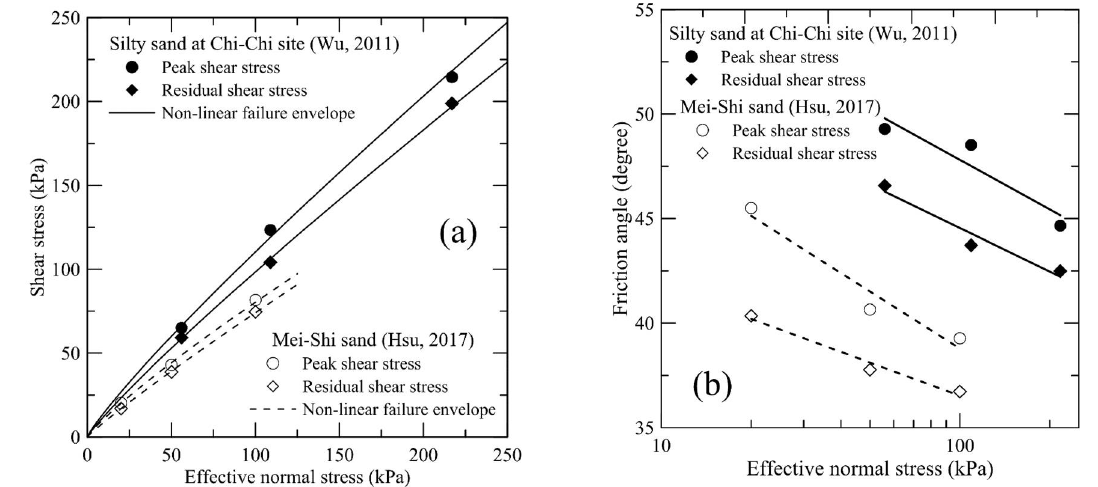
Figure 3. Typical results of direct shear tests: ( a ) Curved M-C failure envelopes and ( b ) Friction angles as logarithmic function of effective normal pressures.